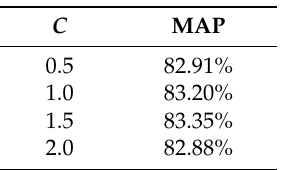
Table 5. Results of MAP using classical tone mapping on KTSD for different values of C